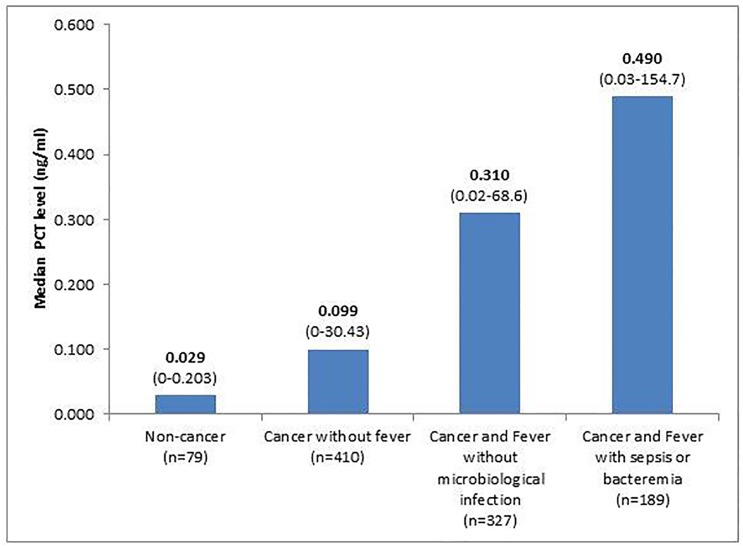
Comparing PCT among different groups of patients.